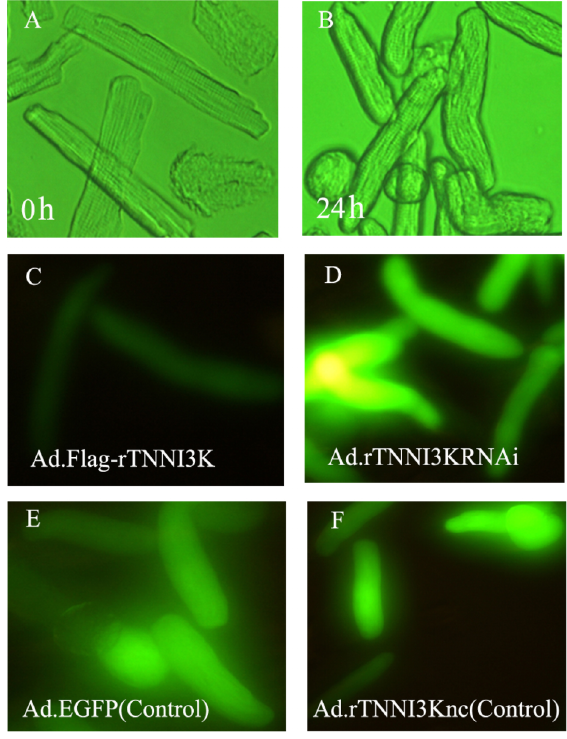
Figure 6. Morphology of rat cardiac myocytes immediately after isolation (0 h) or after 24 h in culture. A and B , Transillumination images. C , D , E , and F , Expression of recombinant adenoviral transgenes in cultured adult rat ventricular myocytes. The rat cardiac myocytes were infected with adenoviral vectors carrying a marker gene, EGFP, at 100 multiplicity of infection after 24 h in